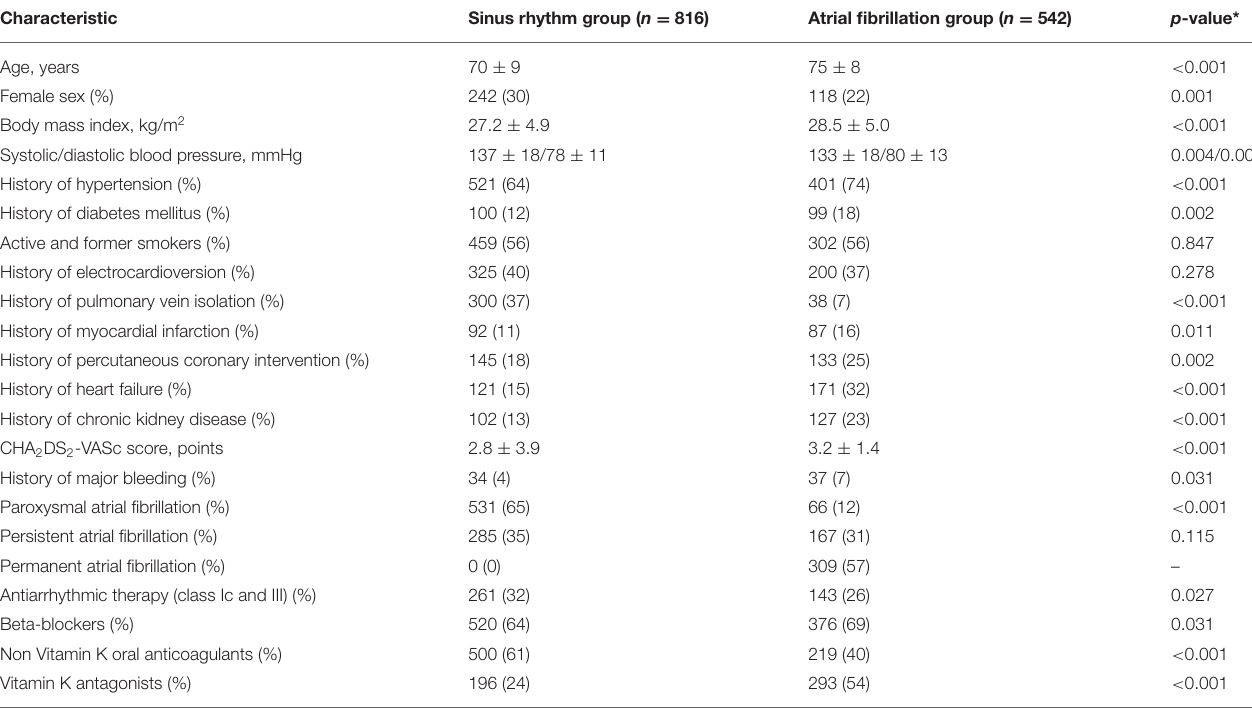
TABLE 1 | Characteristics of the patients stratified by baseline rhythm.